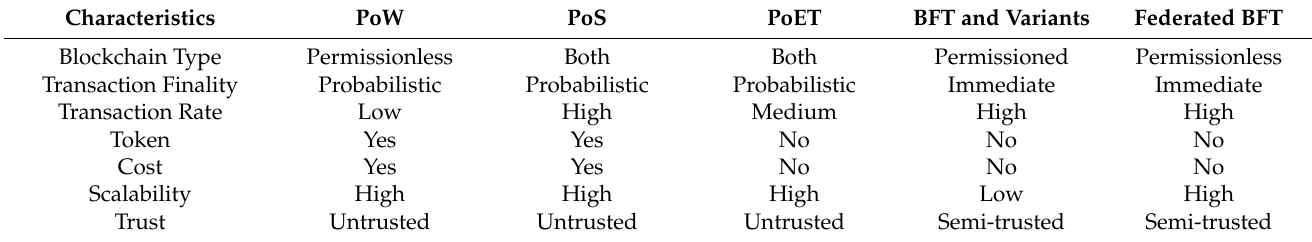
Table 1. Consensus Protocol. PoW—proof of work; PoS—proof of stake; PoET—proof of elapsed time; BFT—Byzantine fault